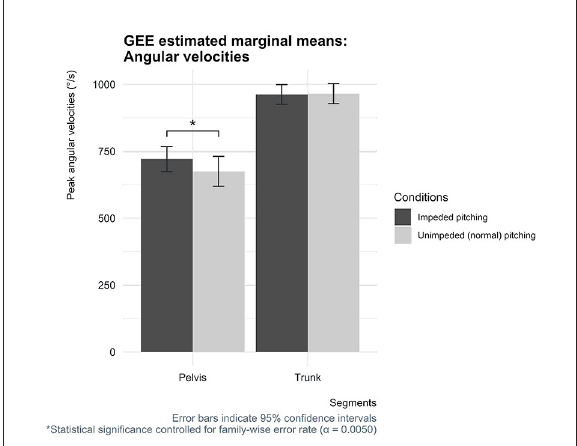
FIGURE7 Estimated marginal means for the peak angular velocities of the pelvis and trunk for both conditions with corresponding 95% confidence interval error bars.